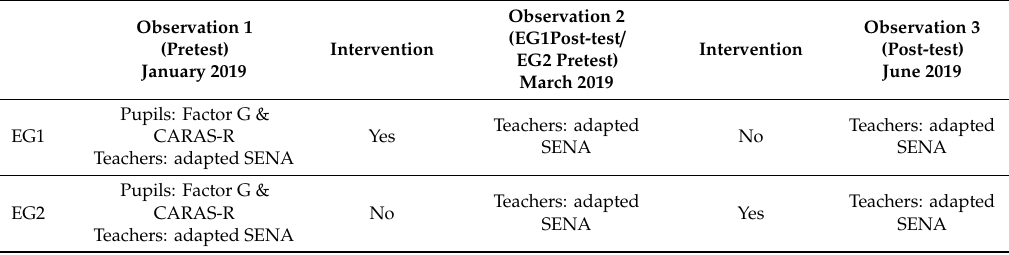
Table 5. The sequence of testing and